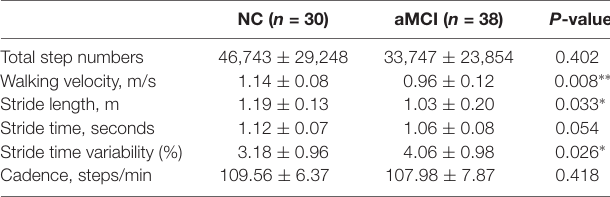
TABLE 2 | Characteristic of gait patterns between groups.